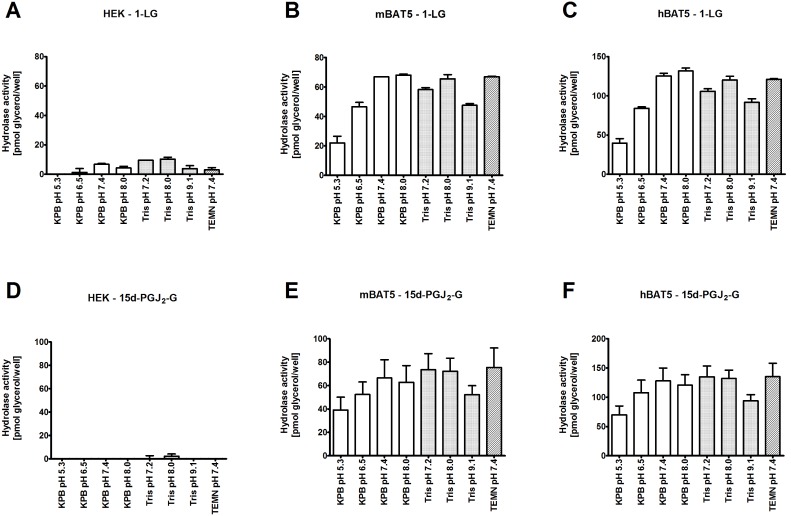
pH optima of mouse (m) and human (h) BAT5 hydrolase activities towards 1-LG and 15d-PGJ2-G.Lysates (0.3 µg/well) of HEK293 cells transiently expressing mBAT5 (B, E) or hBAT5 (C, F) were incubated at the indicated pH for 60 min using 1-LG (A, B, C) or 15d-PGJ2-G (D, E, F) as the substrate (25 µM final concentration). For comparative purposes, substrate hydrolysis in lysates of parental HEK293 cells is also illustrated (A, D). The incubations additionally contained 0.1% (v/v) ethanol, 0.1% (v/v) DMSO and 0.5% (w/v) BSA. After 60 min incubation, the pH of the assay system was brought to the neutral range by the addition of Glycerol Assay Mix containing additionally 100 mM Tris-HCl, pH 7.4 and THL (10−5 M) to quench hydrolase activity. Assay blanks and glycerol standards were included for each pH condition. Glycerol content was determined at time-point 60 min. The buffer systems were as follows: 10 mM K-phosphate buffer (KPB) covering the pH range 5.3–8.0 and 10 mM Tris-HCl covering the pH range 7.2–9.1. For comparative purposes, hydrolase activity in the routinely used hydrolase assay buffer (TEMN, pH 7.4) is shown. Data are mean + SEM of duplicate wells from two independent experiments.